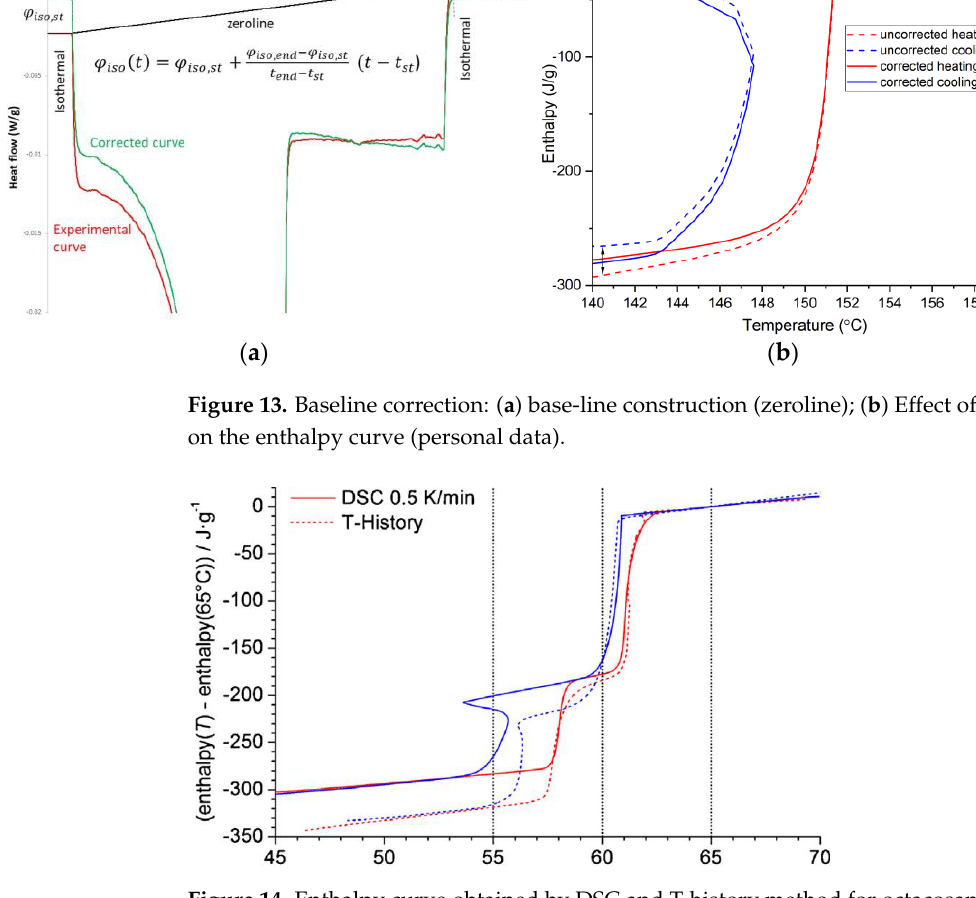
Figure 14. Enthalpy curve obtained by DSC and T-history method for octacosane PCM, after [14]. Table 8. Studies on PCMs’ enthalpy.